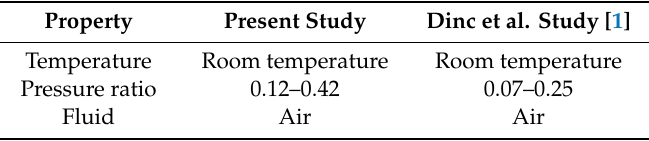
Figure 12. Comparison of metallic-cloth fiber flow performance for all directions of warp, shute, diagonal, and cross. Table 3. Boundary conditions of leakage